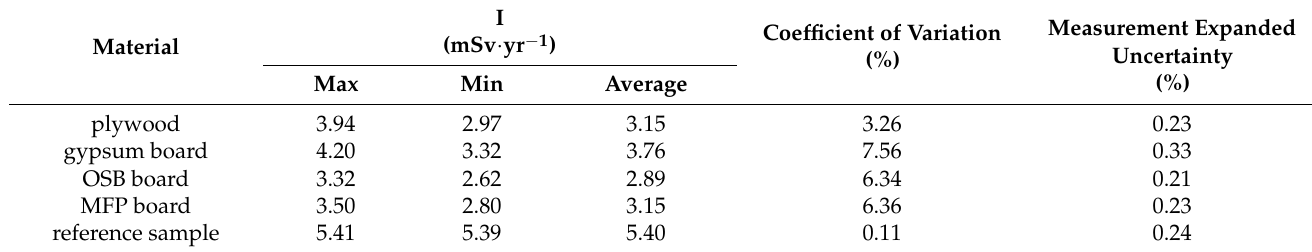
Table 5. Radioactivity concentration index measured for finishing